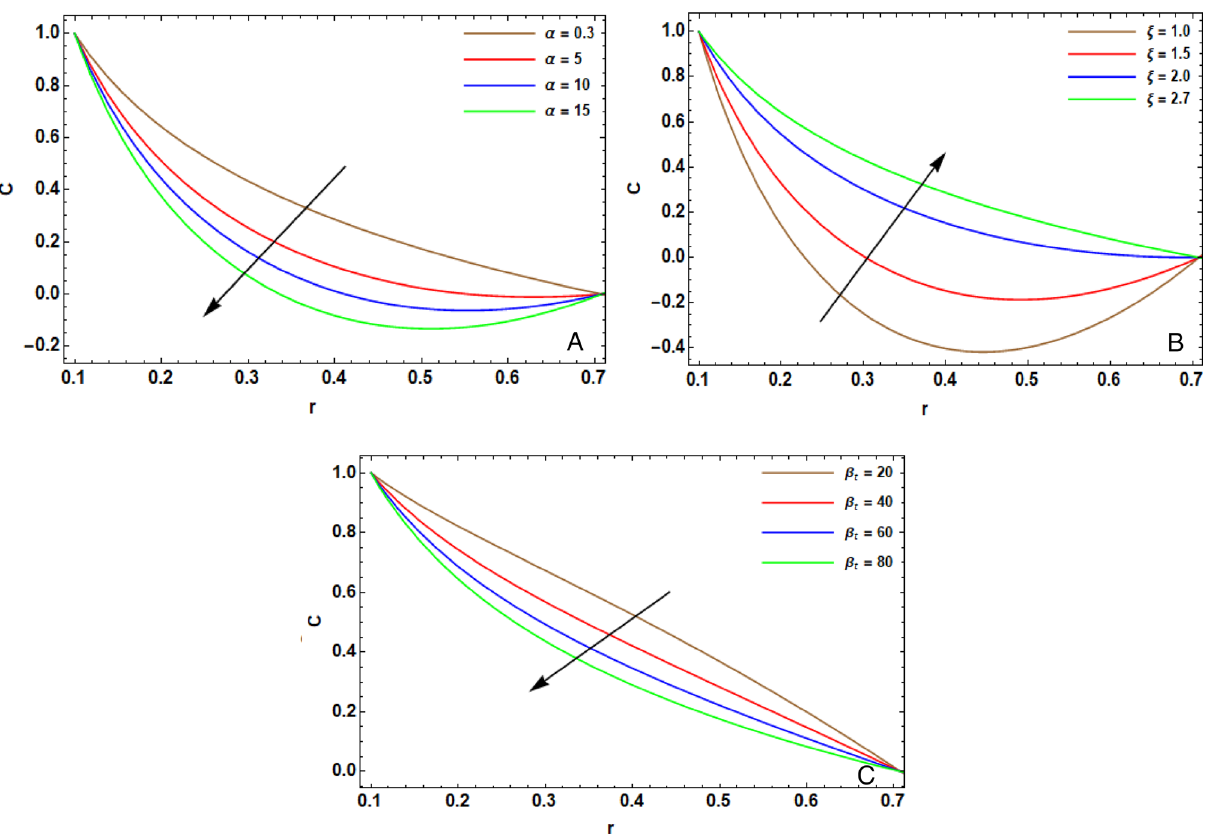
Figure 5. ( A ) implies alteration C ( r ) for diverse amounts of α . ( B ): implies alteration C ( r ) for diverse amounts of ξ . ( C ) implies alteration of C ( r ) for diverse amounts of β t .